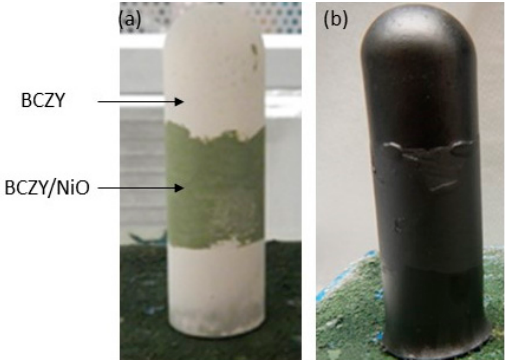
Figure 7. BCZY27-NiO/BCZY27/BCZY27-NiO symmetric cell tube: ( a ) before and ( b ) after sintering.